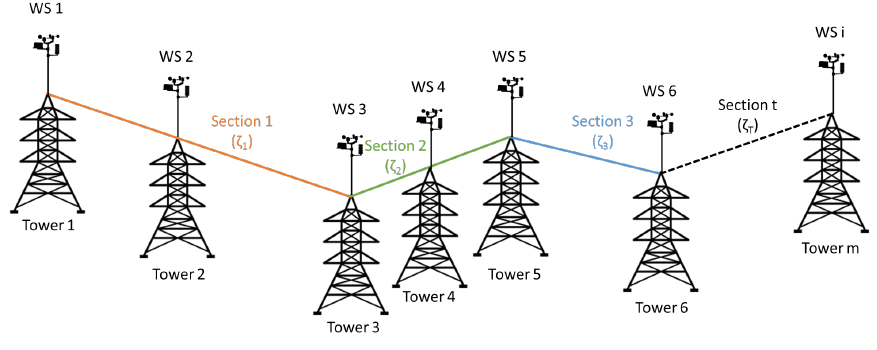
Figure 5. Parts of a theoretical